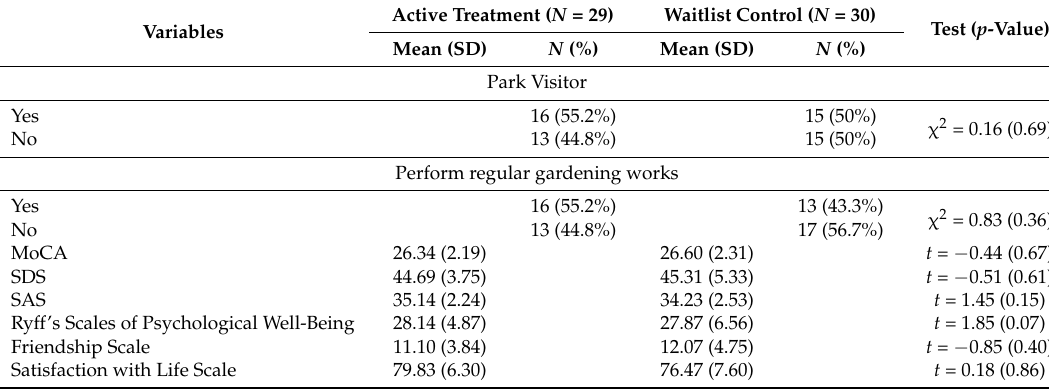
Table 3. Results from the analyses of biomarkers measurements at baseline, 3-months and 6-months post-intervention. Biomarkers